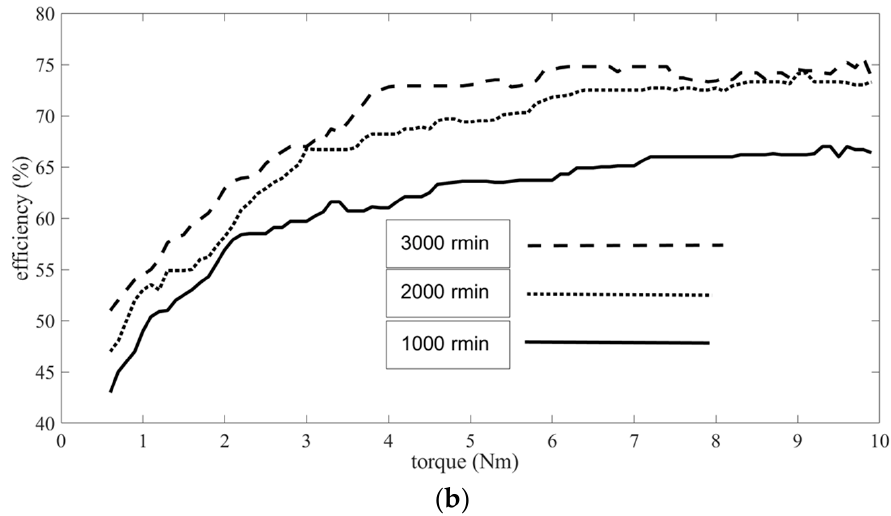
Figure 9. Efficiency test of different rotating speeds and shut-off angles. ( a ) Efficiency comparison of different rotating speeds when the turning off angle is 108°. ( b ) Efficiency comparison of different rotating speeds with a turning-off angle of 129°.